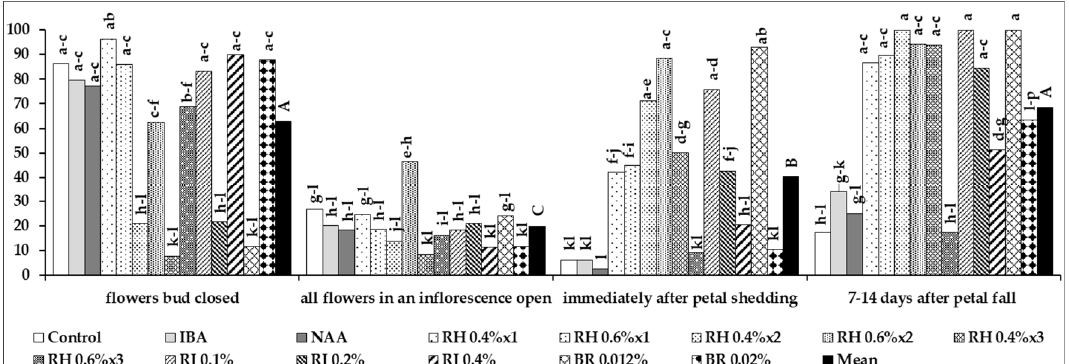
Figure 5. The influence of rooting enhancers on percentage of rooted cuttings created new shoot (%) in Rosa ‘Maiden’s Blush’ harvested in four phenological stages of shoot. Control—the control cuttings; IBA 0.4%—Ukorzeniacz A aqua (0.4% IBA); NAA 0.2%—Ukorzeniacz B aqua (0.2% NAA); RH 0.4%×1, RH 0.6%×1—watering with 0.4% or 0.6% Bio Rhizotonic (10 mL) after planting; RH 0.4%×2, RH 0.6%×2—watering with 0.4% or 0.6% Bio Rhizotonic (10 mL) after planting and 10 days later; RH 0.4%×3, RH 0.6%×3—watering with 0.6% Bio Rhizotonic (10 mL) after planting, 10 and 20 days later; RJ 0.1%, RJ 0.2%, RJ 0.4%—watering with 0.1%, 0.2%, or 0.4% Root Juice™ (10 mL) after planting; BR 0.012%, BR 0.02%—watering with 0.012% or 0.02% Bio Roots (10 mL) after planting. Different small letters indicate significant interactions between phenological stage and treatment (two ‐ way ANOVA). Different capital letters indicate significant differences between phenological stages. The Duncan’s test ( α = 0.05) was used.